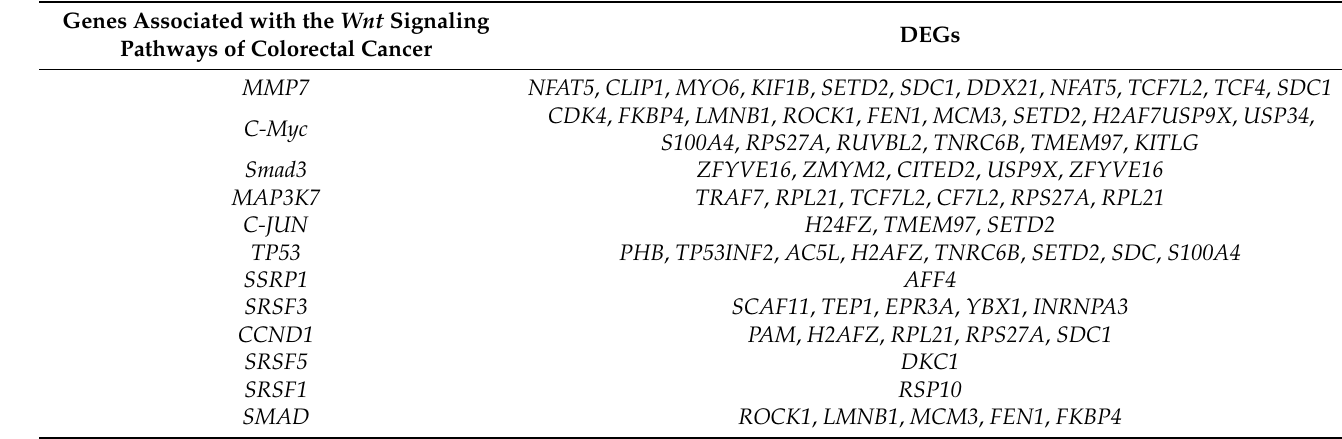
Table 3. Interaction of the key genes of the Wnt signaling pathways of colorectal cancer with the DEGs identified as histone modifier genes.